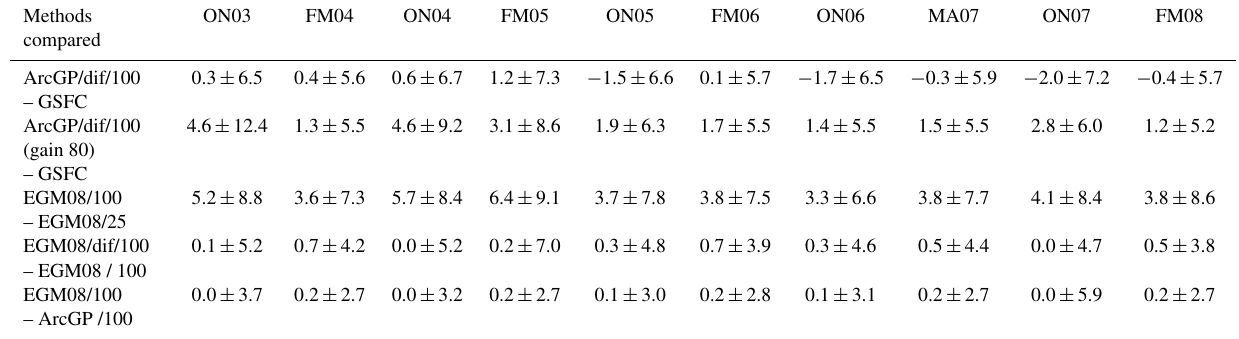
Table 2. Mean ± SD of the differences between freeboards estimated using different averaging scales and geoids (cm). The compared methods are indicated by the used geoid (ArcGP or EGM08), geoid adjustment is indicated by dif, scale of along-track averaging is indicated by 100 (i.e. applying 50 and 100km windows for estimating ¯ h and h sl ) and 25 (i.e. applying 25km windows for estimating ¯ h and h sl ) . Methods ON03 FM04 ON04 FM05 ON05 FM06 ON06 MA07 ON07 FM08 compared ArcGP/dif/100 0.3 ± 6.5 0.4 ± 5.6 0.6 ± 6.7 1.2 ± – GSFC